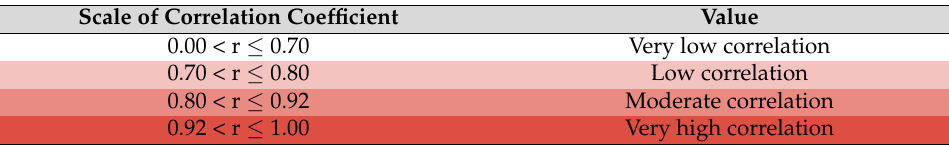
Figure 1. Heatmap clustering, KEGG pathway, and PCA analysis for all the RNA-Seq samples. ( a ) The heatmap of the distance matrix obtained with the DESeq2 package on regularized-logarithm transformed counts showing an overview of similarities and dissimilarities between the RNA-Seq samples. The heatmap shows three distinct groups of cells (YD-8 + YD-8/CIS, YD-9 + YD-9/CIS, and YD-38 + YD-38/CIS) and within each group, there were two subgroups of cells (cisplatin-resistant cells and parental cells). Red indicates upregulated genes and blue indicates downregulated genes ( q -value < 0.05). ( b ) Expression of genes in cancer pathways in parental samples and cisplatin-resistant samples. Genes in the colored box have significantly different expression. Red indicates upregulated genes and blue indicates downregulated genes. ( c ) PCA plot of the overall gene expression, showing the separation of YD-8/CIS and YD-9/CIS cells from other cells. PCA is based on the abundances of all transcripts detected in the RNA-Seq analysis. The color legend is reported at the bottom of the plot. Table 2. The scale of Pearson’s correlation